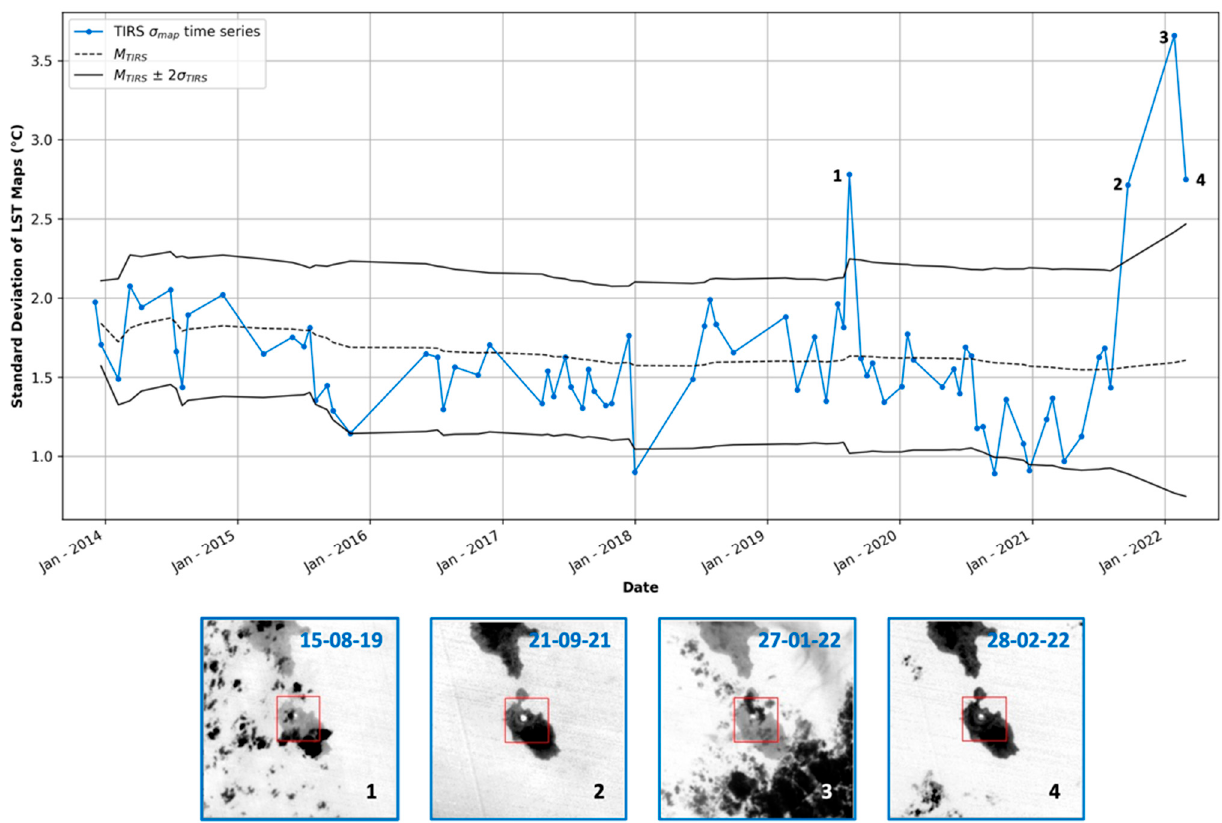
Figure 10. σ TIRS and M TIRS value for the entire TIRS dataset (Up): Visual analysis for the 15 August 2019, 21 September 2021, 27 January, and 28 February 2022, outliers (down, 1; 2; 3; 4 respectively).